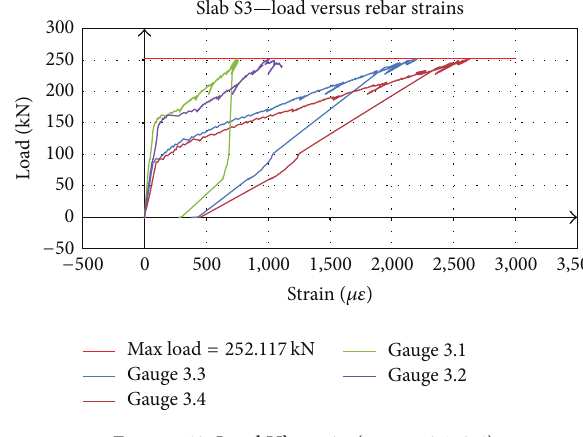
Figure 43: Load V’s strain (gauges 3.1–3.4).